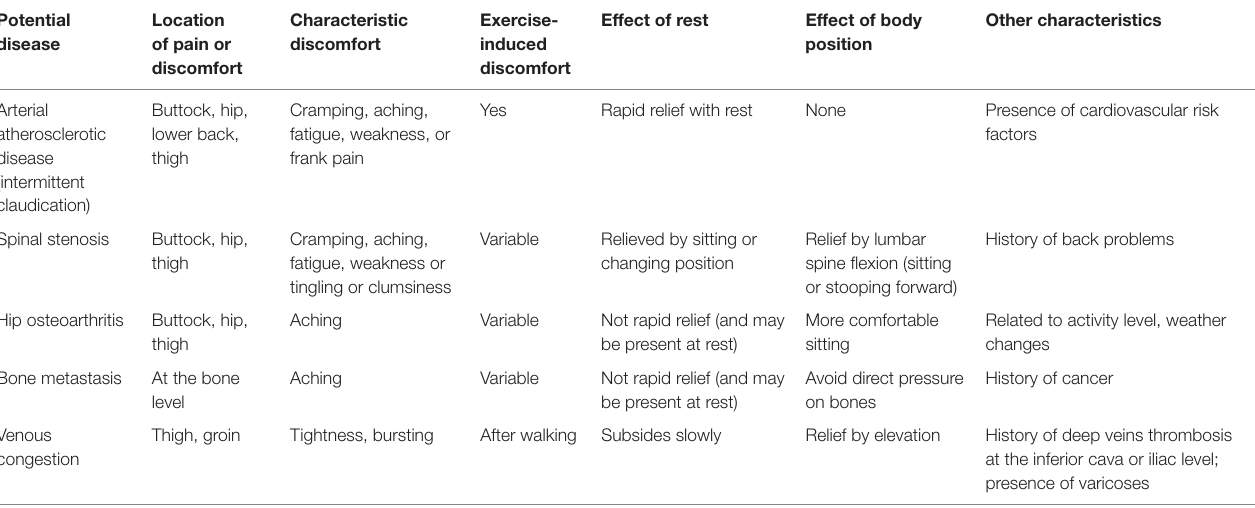
TABLe 1 | Differential diagnosis of internal iliac artery stenosis.